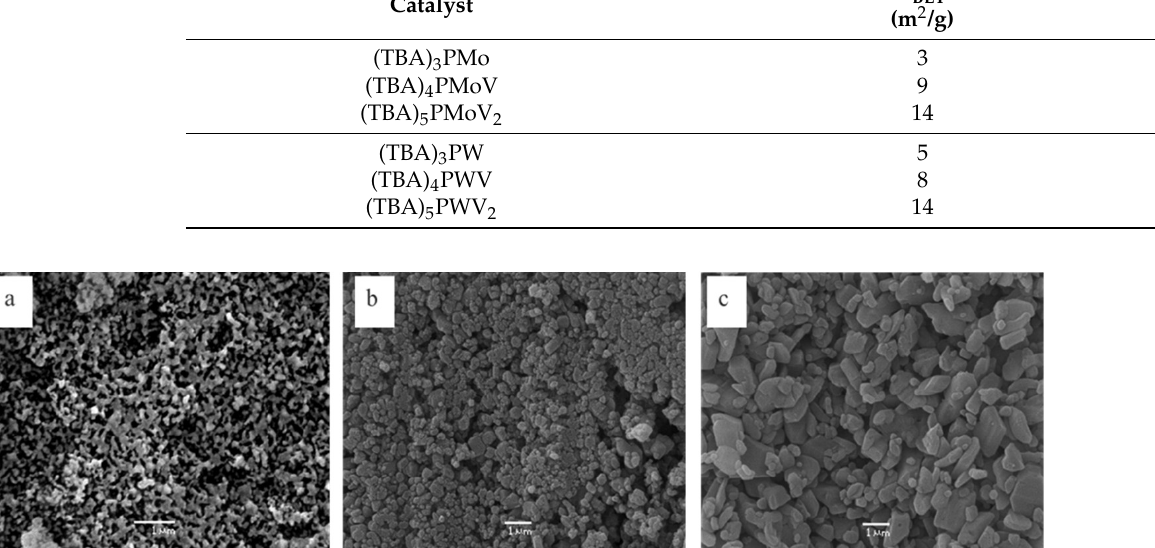
Figure 7. HLPC-DAD chromatogram of oxidation products of benzyl alcohol at 4 h. Benzaldehyde was the only reaction product, as confirmed by GC-MS. The liquid-phase aerobic catalytic oxidation of benzyl alcohol to benzaldehyde con- version results are shown in Figure 8a and Figure A2) (at 4 h of reaction and selectivity at a 100% conversion level) for the Mo and W materials. Figure 8. Total conversions ( a ) (%, color bars) and rate constants ( b ) (s − 1 , grey bars) of the liquid- phase aerobic oxidation of benzyl alcohol at 4h for pure and substituted Mo and W catalysts ( n = 3).